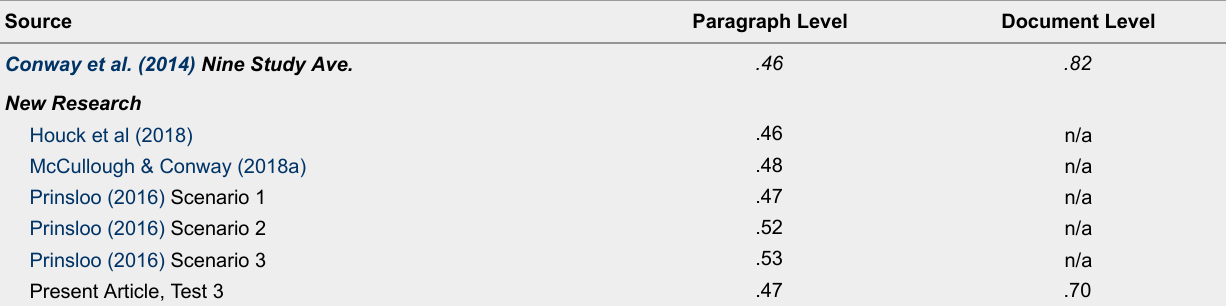
Document LevelParagraph LevelSource